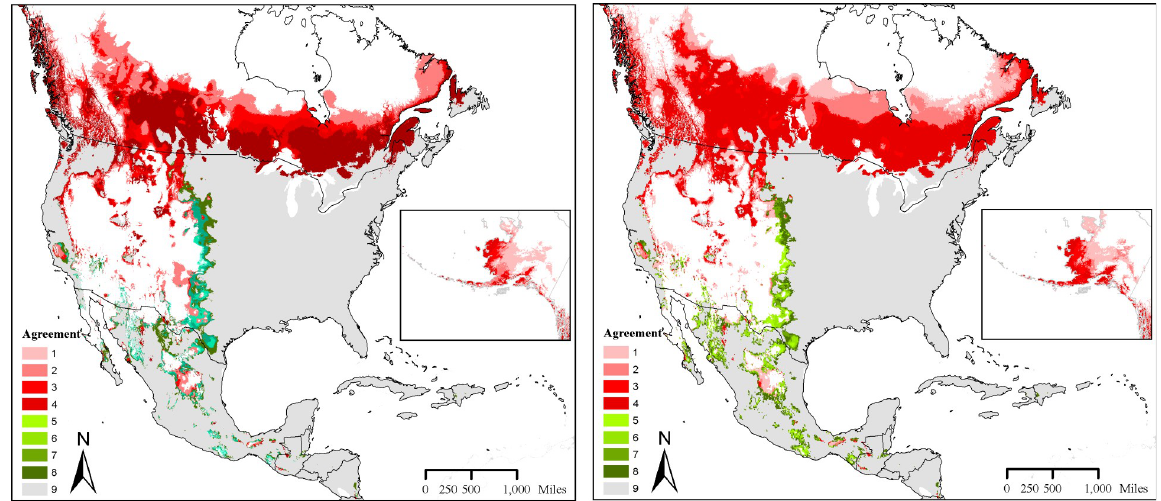
Fig 3. A. Predicted distribution of suitable regions under the Representative Concentration Pathway (RCP) 4.5, and agreement between different Global Circulation Models. B. Predicted distribution of suitable regions under the Representative Concentration Pathway (RCP) 8.5, and agreement between different Global Circulation